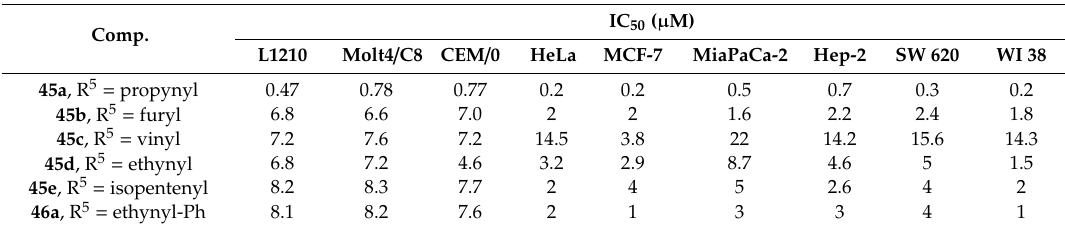
Table 17. The cytostatic activities of C-5 aryl-, alkenyl-, and alkynyl-substituted uracil derivatives of ASA. Comp.